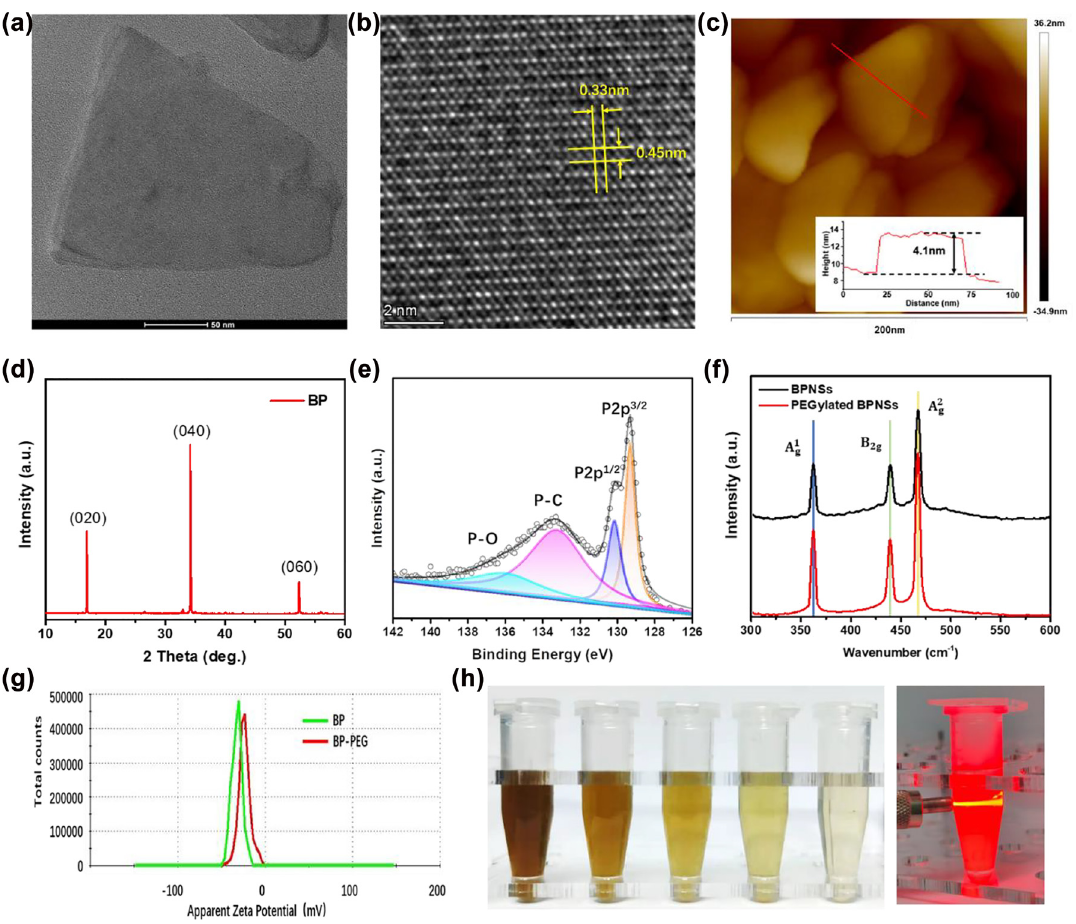
Figure 2: BP characterizations (a), (b) TEM images (c) AFM height analysis, (d) XRD spectra, (e) high-resolution XPS spectra of P2p, (f) Raman spectra of BP and BP-PEG, (g) zeta potential analysis of before and after PEG covered BP, (h) photographs of BP-PEG solutions with various concentration, BP dispersion with laser